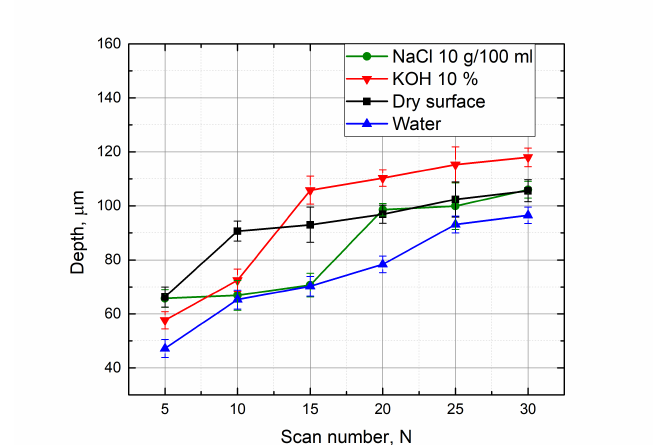
Figure 8. Depth of the grooves formed in the glass sample in dependence on the scan number. Grooves were formed while the sample surface was dry and immersed in different liquids—10% KOH, 10 g/100 mL NaCl aqueous solutions, and water. Scanning speed—100 mm/s, number of scans—15, average power—5 W, pulse repetition rate—60